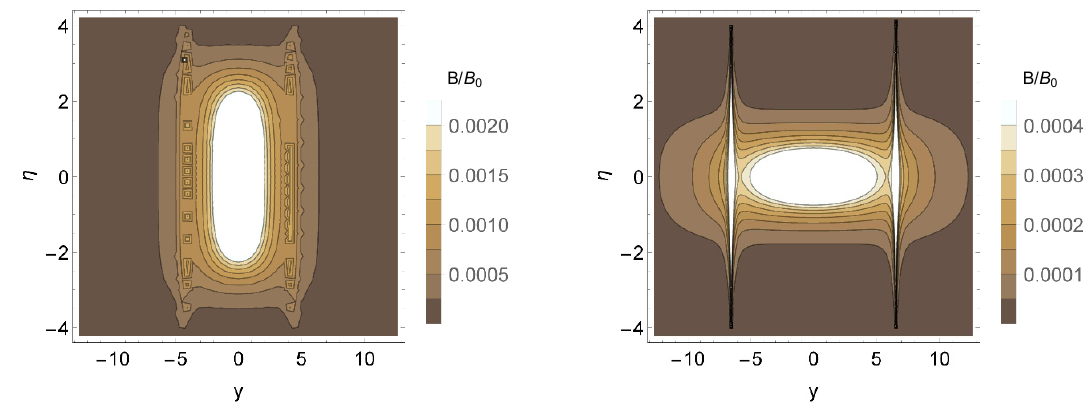
Figure 3 . (color online). The magnitude of the magnetic (cid:12)eld in y (cid:0) (cid:17) plane from current free solution, i.e. eq. (4.1) using parameters (cid:12)xed in (6.7) for ! 1 = 0 : 5 ; ! 2 = 0 : 05 at (a) (cid:28) = 0 : 4 fm = c and (b) (cid:28) = 5 fm = c. The value of B 0 depends on the choice of parameters, but the overall behavior is independent. The white areas are in the neighborhood of a singularity, and the magnetic (cid:12)eld is much larger than other parts.